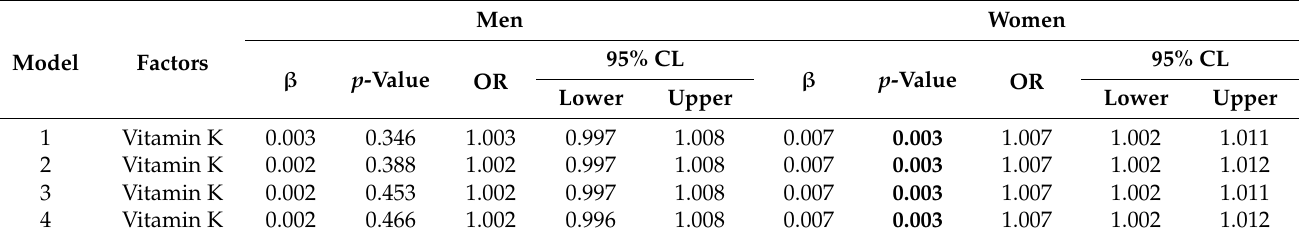
Table 5. Relationship between vitamin K and the RS stratified by